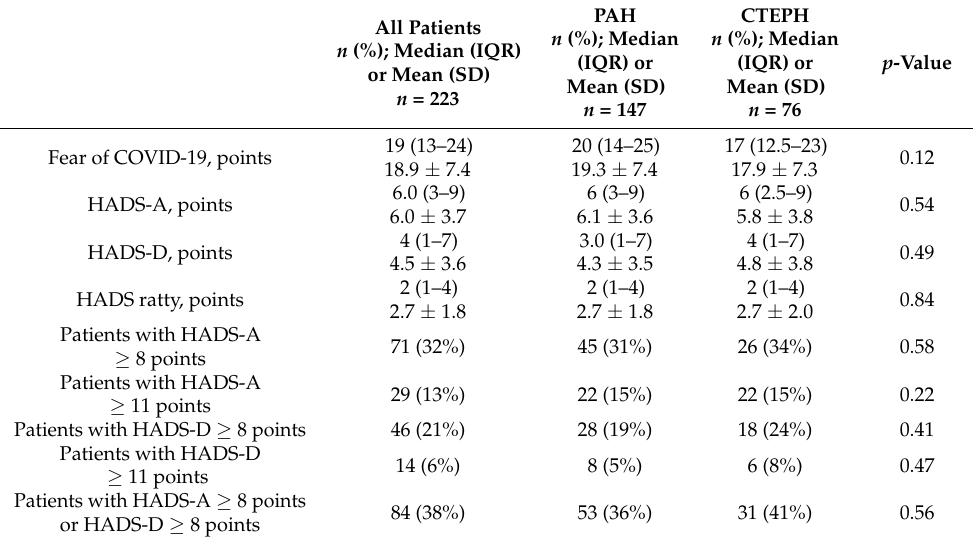
Table 2. Median and mean scores in FCV-19S, HADS-A, HADS-D, and HADS-R in the general study group.